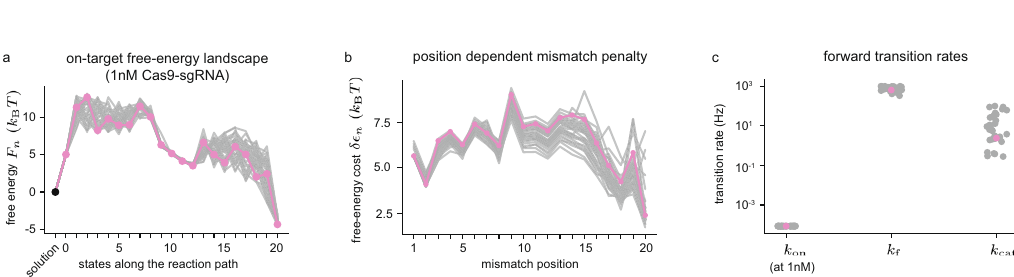
Fig. 4 Physical parameters estimated from NucleaSeq and CHAMP datasets. a The on-target free-energy landscape F n for (d)Cas9-sgRNA at the reference concentration 1 nM. The solution state (black dot) is taken as a reference for the free energy, and set to 0 k B T . State 0 is the PAM-bound state, and the remaining states are the R-loop states with hybrid length 1 – 20 bp. Three well de fi ned local minima separated by barriers are visible, indicating that there are three meta-stable states in the system. b Energetic penalties δ ϵ n incurred by mismatches as a function of position n in the hybrid. c) The estimates for the on-rate at 1 nM Cas9-sgRNA concentration ( k on ), the internal forward rate ( k f ), and the bond-cleavage catalysis rate ( k cat ). In all fi gures, the 33 near-equivalent solutions (see text) are plotted in grey, with the optimal solution highlighted in pink (Supplementary Data